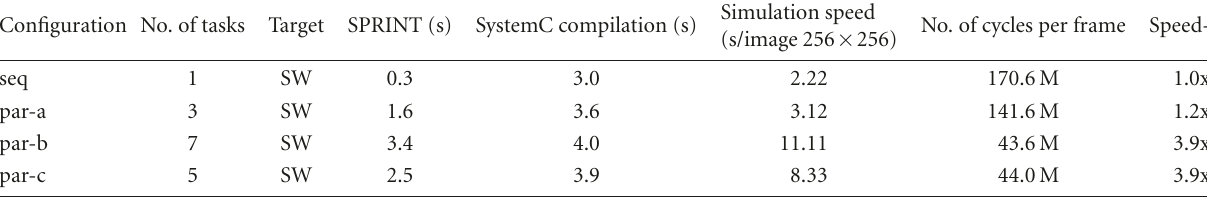
Table 2: Experimental results for the EZT coder (801 lines of sequential C